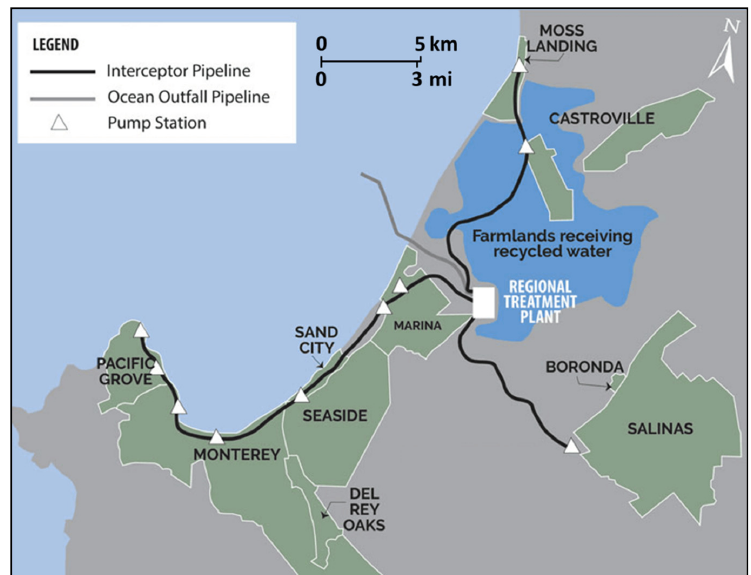
Figure 2. Monterey One Water member entities include Boronda County Sanitation District, Castroville Community Services District (including Moss Landing), Del Rey Oaks, Marina Coast Water District, Monterey, Pacific Grove, Salinas, Sand City, Seaside, and Monterey County (adapted from [24]).